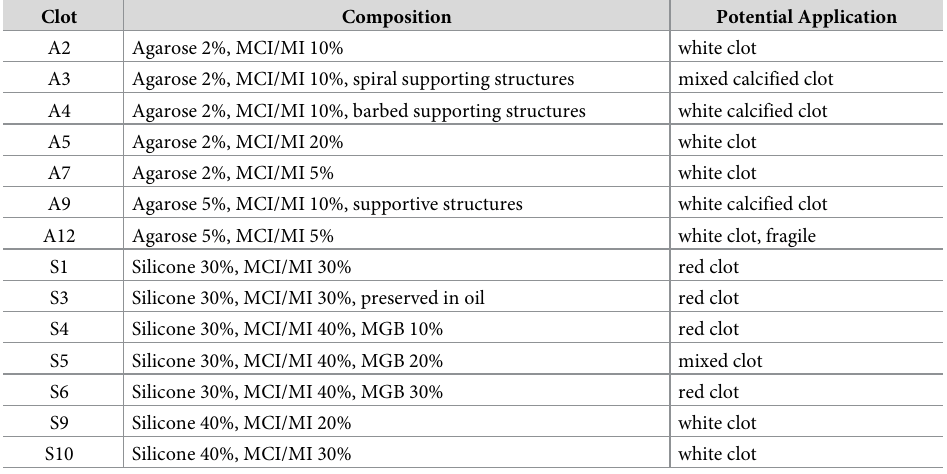
Table 1. Summary of selected synthetic clots, their general composition and possible